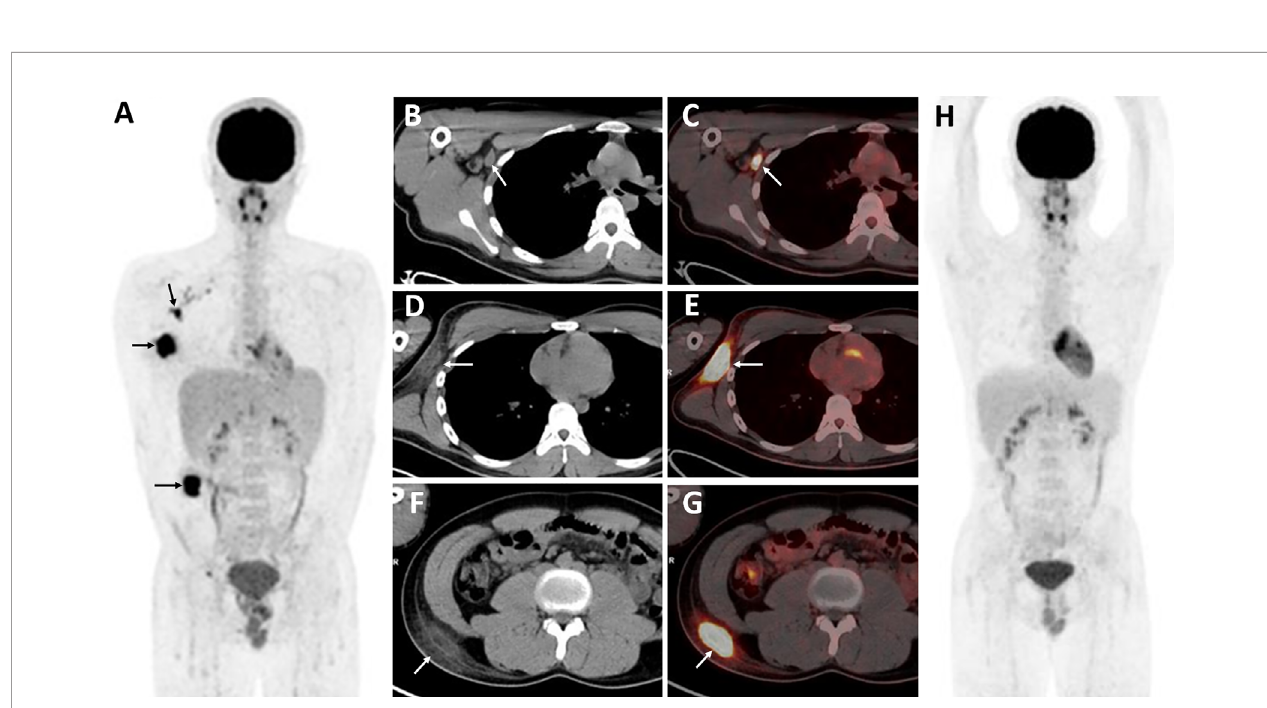
FIGURE 6 | Eighteen-year-old male with subcutaneous panniculitis-like T-cell lymphoma. Three-dimensional maximum intensity projection image (A) shows three intensely 18 F-FDG-avid lesions in the right side of the body (black arrows). Corresponding axial CT (B, D, F) and fusion PET/CT (C, E, G) images clearly show an enlarged lymph node with increased uptake of 18 F-FDG in the right axillary and ill-de fi ned lesions in the subcutaneous adipose of the body, representing sites of lymphoma. The patient achieved complete remission after chemotherpay (H)